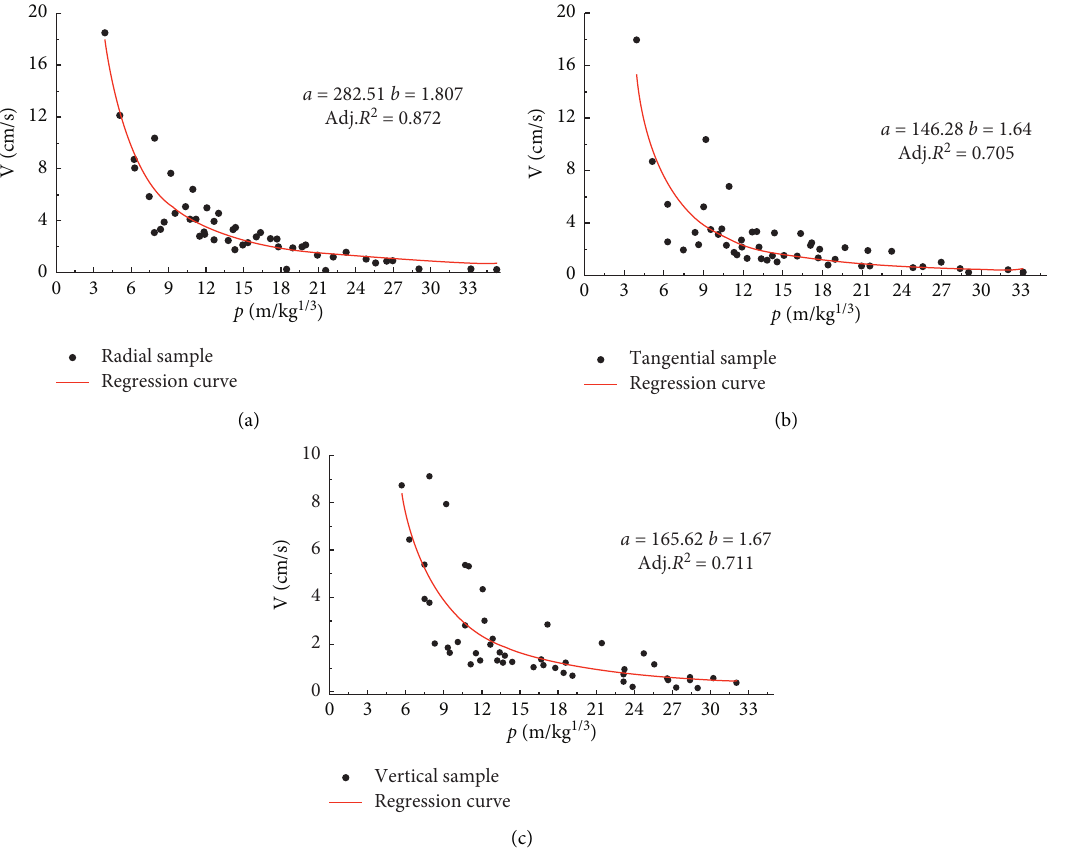
Figure 7: The regression curve of (a) radial velocity, (b) tangential velocity, and (c) vertical